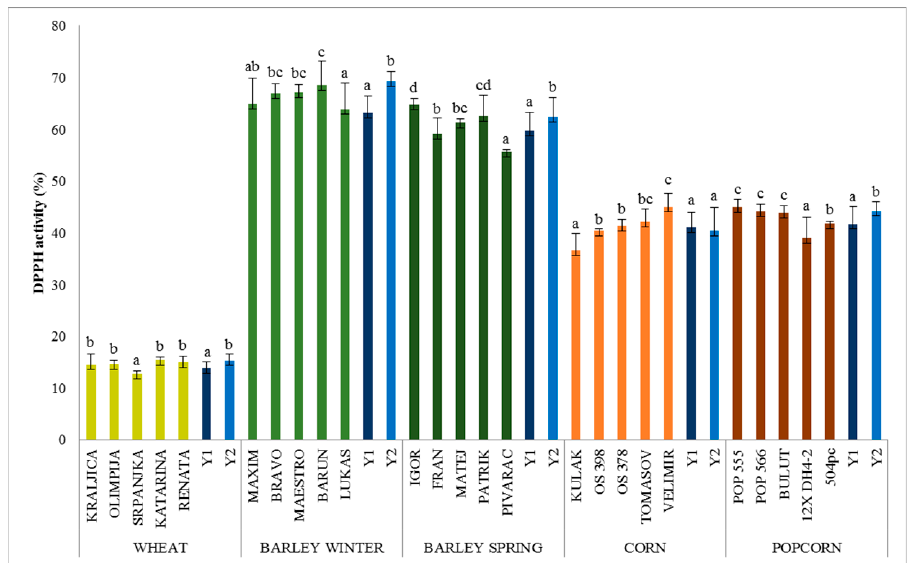
Figure 2. DPPH radical scavenging activity (%) in cereal grains. Mean ± SD of 2 years and triplicate extraction ( n = 6). Bars with different superscript letters (a-d) are significantly different ( p < 0.05).